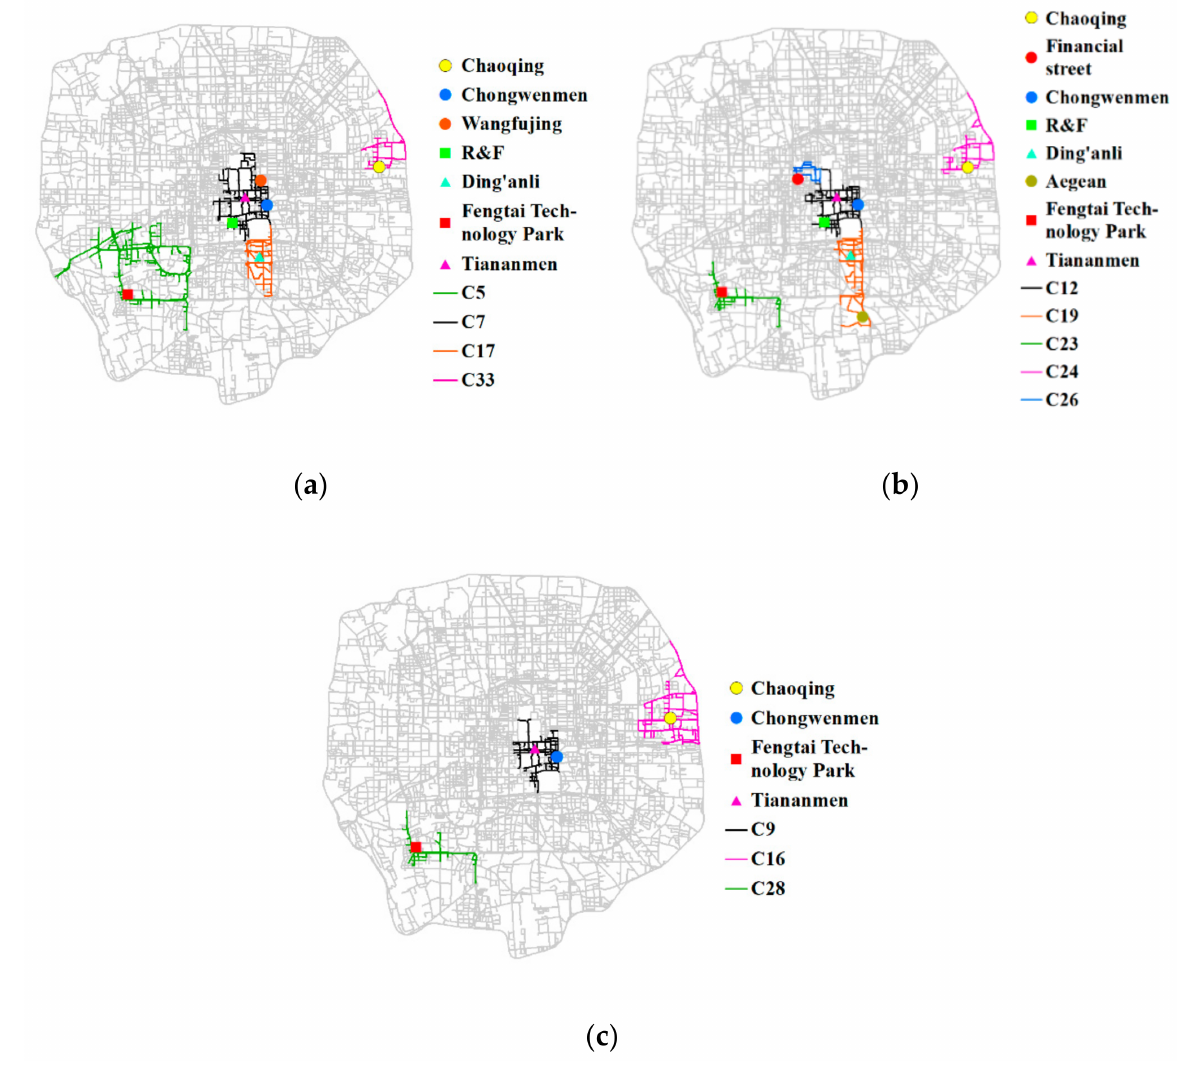
Figure 15. Some communities identified by EACO: ( a ) 8:00–9:00; ( b ) 9:00–10:00; ( c ) 10:00–11:00. Community C 7 at 8:00–9:00 contains some commercial areas and workplaces (e.g., Chongwenmen business district, Wangfujing business district, Tiananmen